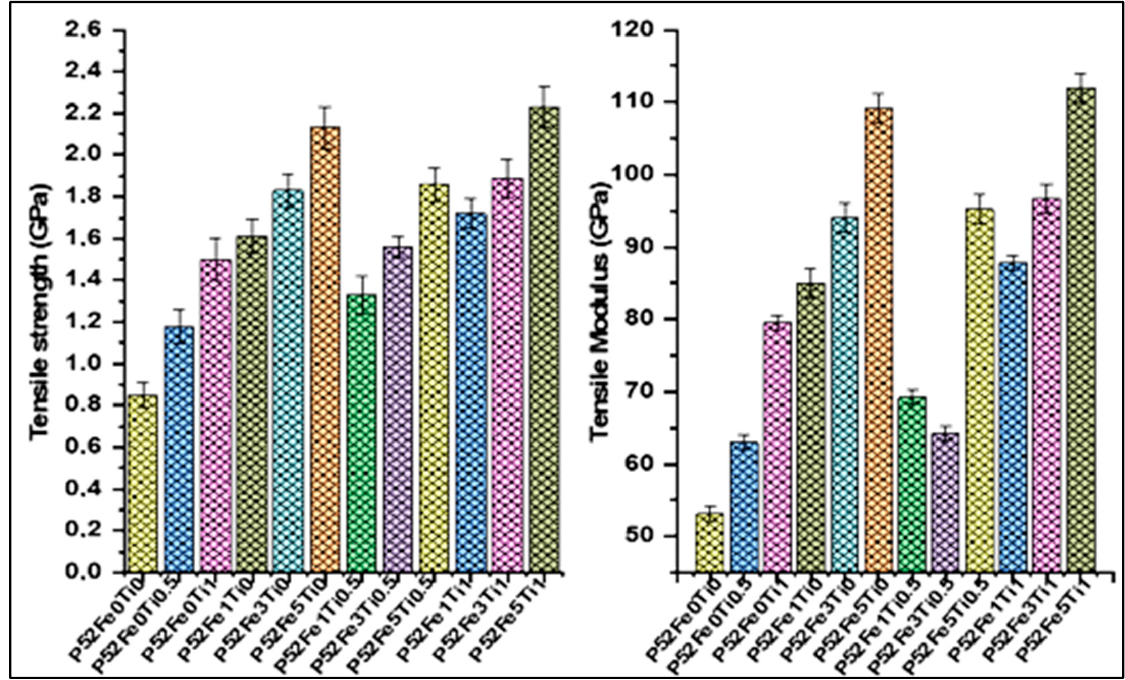
Figure 5. Tensile strength and tensile modulus of phosphate glass fibers.